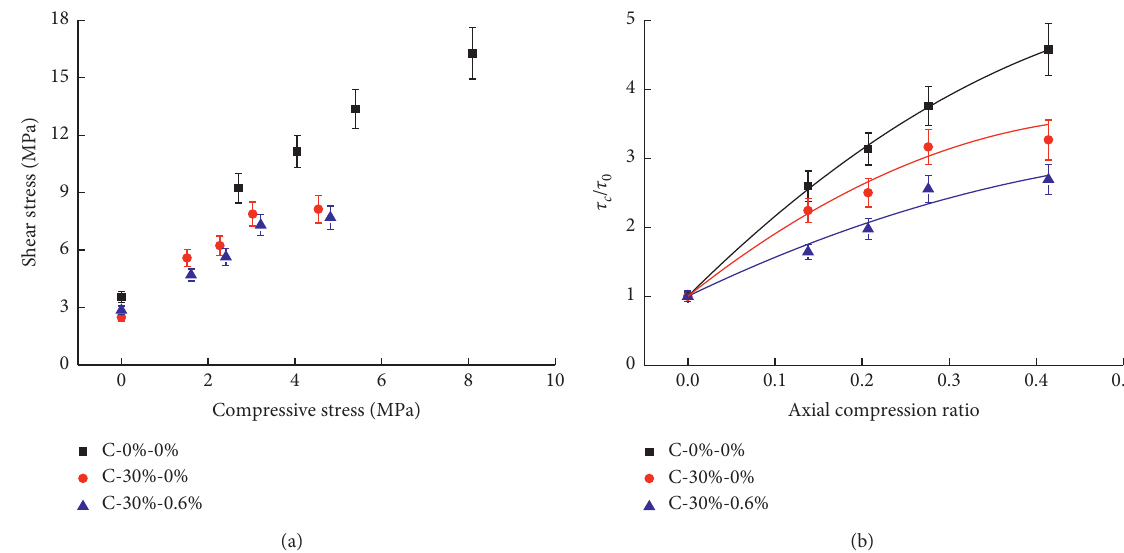
Figure 9: The relationship between the axial compression stress of rubber fiber concrete and the shear action. (a) Axial compression stress and shear stress. (b) Axial compression ratio and shear stress variation